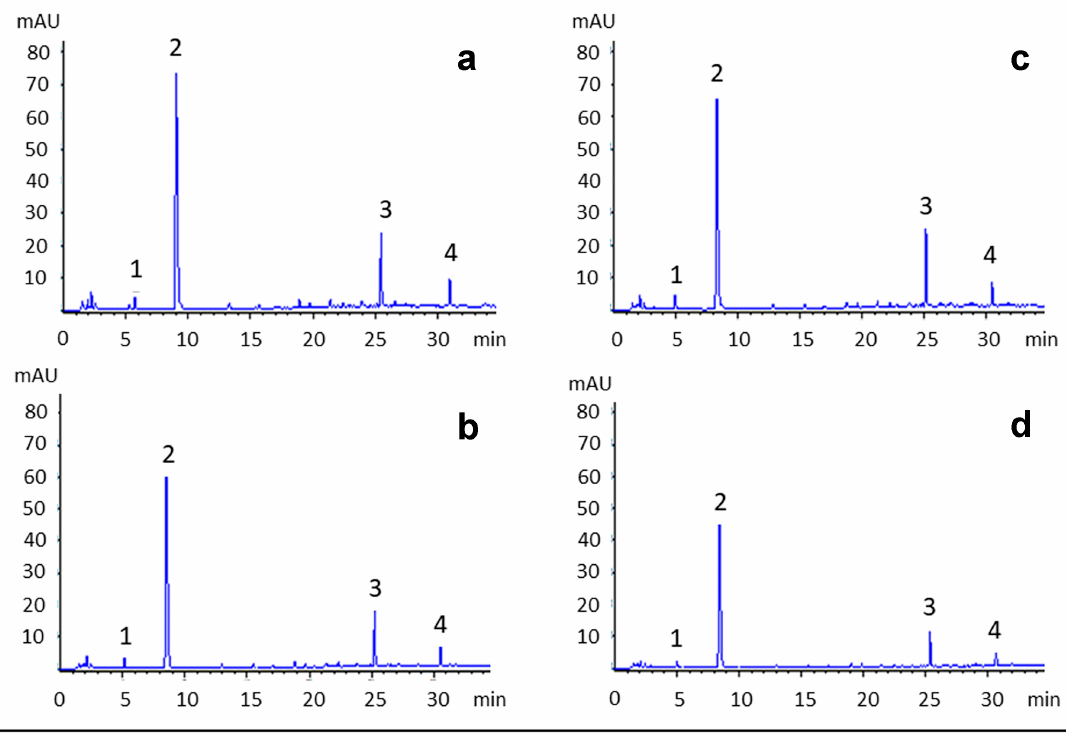
Figure 6. HPLC-UV chromatograms of onion extracts ( a , c ) and the residues after the dyeing process ( b , d ) in the absence ( a , b ) and in the presence ( c , d ) of the surfactant, acquired at 254 nm. Peak identification: 1. protocatechuic acid-glucoside, 2. protocatechuic acid, 3. quercetin-3- O -glucoside, 4. quercetin. Table 3. Quantitative analysis of protocatechuic acid, quercetin, and their glucosides in onion extracts and their residue after dyeing procedures. Data are expressed as mean ( n = 3) ± SD.